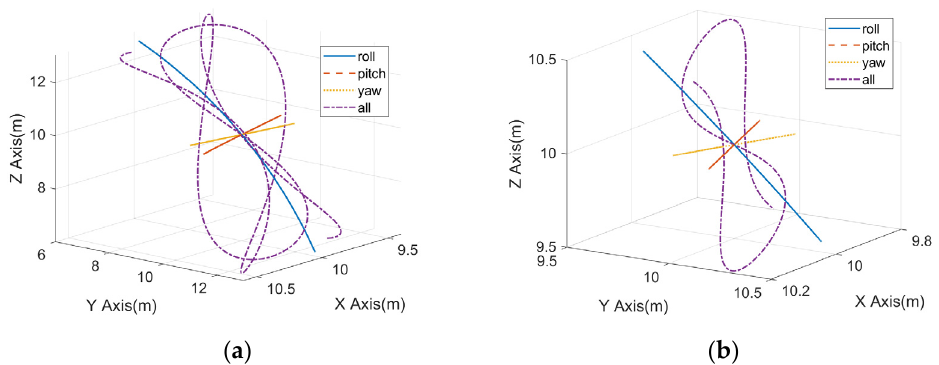
Figure 7. The trajectories of point P in the fixed space coordinate system during 30 s. ( a ) Point oscillates with the destroyer; ( b ) point oscillates with the carrier.